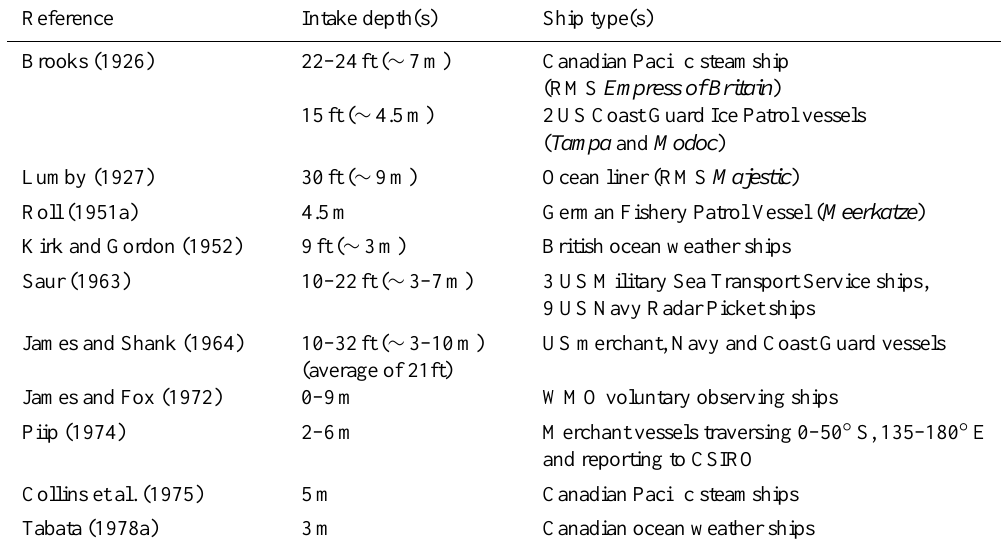
Table 1. Intake depths reported from observing ships of various type in pre-1980 literature. All are from ships contemporary to the publication year except Collins et al. (1975), which are from vessels operating during 1927 to 1933. CSIRO is the Commonwealth Scientific and Industrial Research Organisation of Australia.